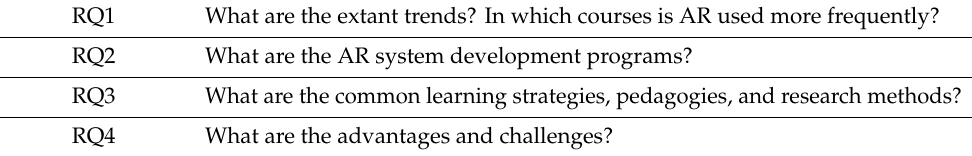
Table 1. Research questions concerning applying augmented reality (AR) in architectural and civil engineering (ACE) education. RQ1 What are the extant trends? In which courses is AR used more frequently? RQ2 What are the AR system development programs? RQ3 What are the common learning strategies, pedagogies, and research methods? RQ4 What are the advantages and